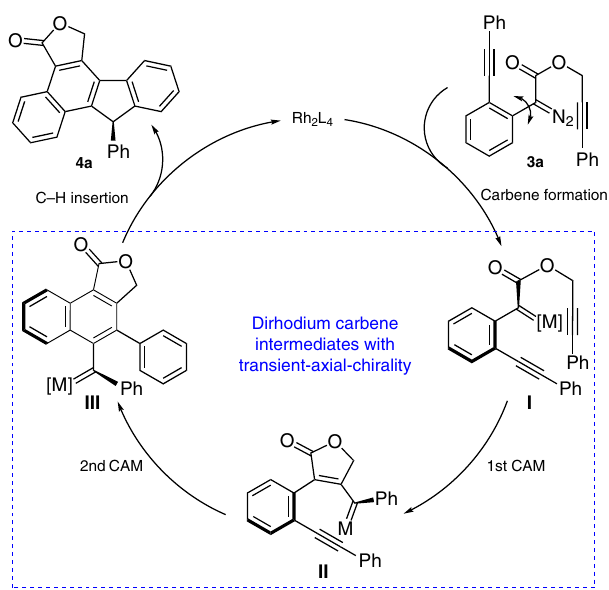
Fig. 5 Overview of the catalytic cycle. The dual-carbene/alkyne metathesis process through the formation of the carbene intermediates with axial chirality.